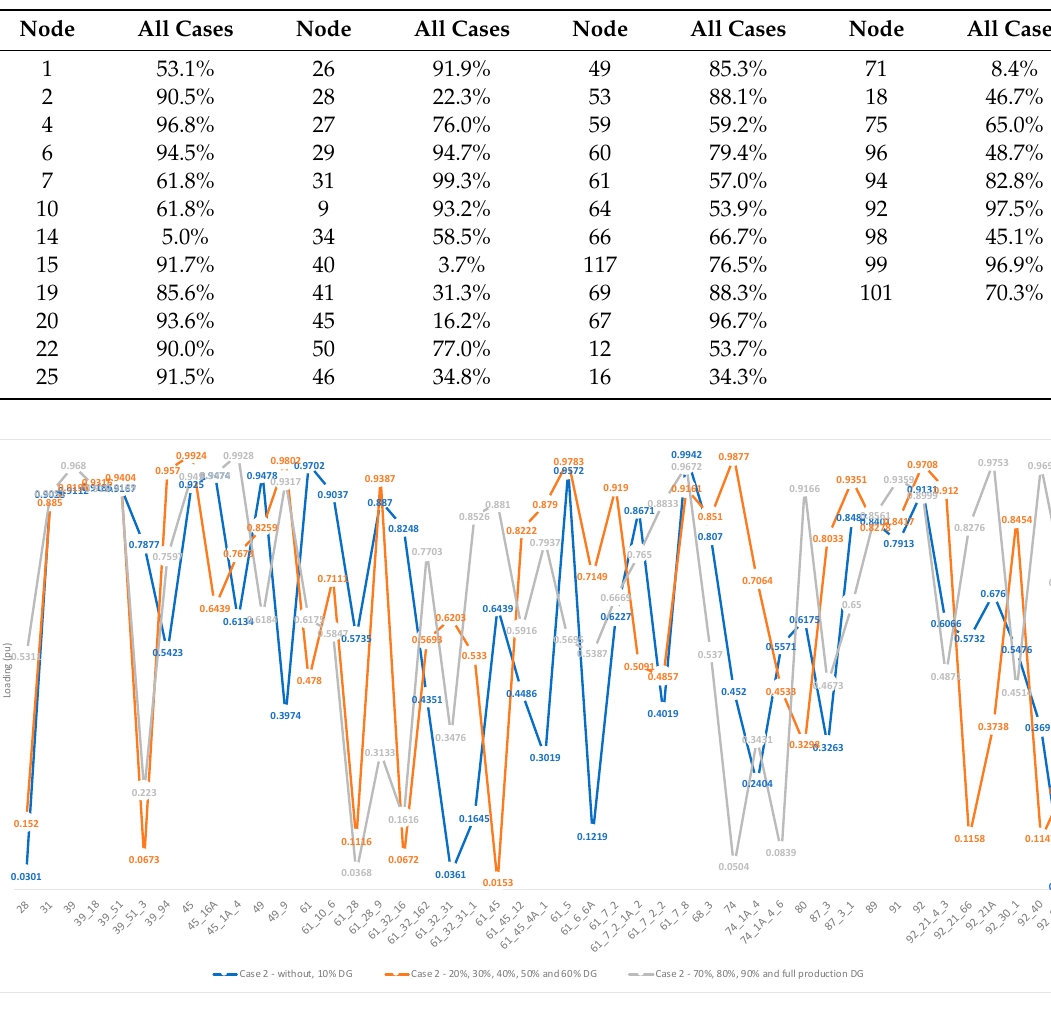
Table 9. Loading per node for case 4.